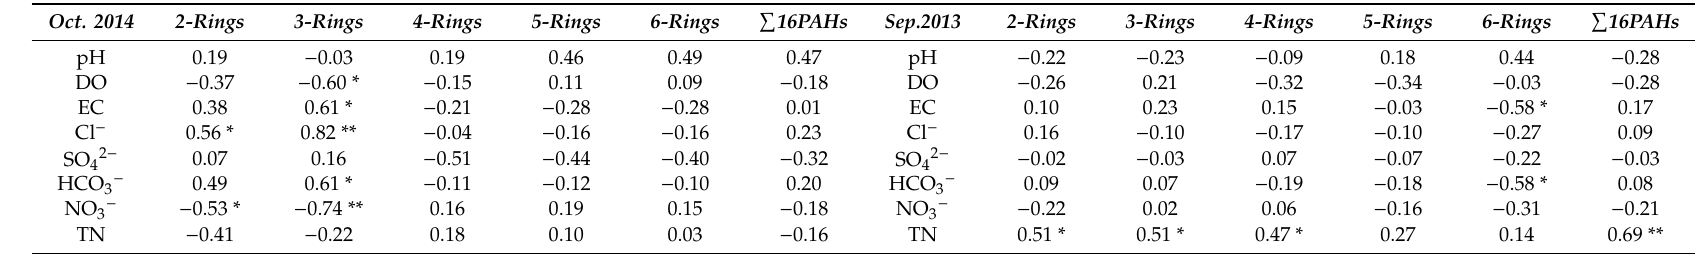
Table 3. Pearson correlation coe ffi cient of PAHs compositions with physical-chemical parameter and ionic concentrations in river water.